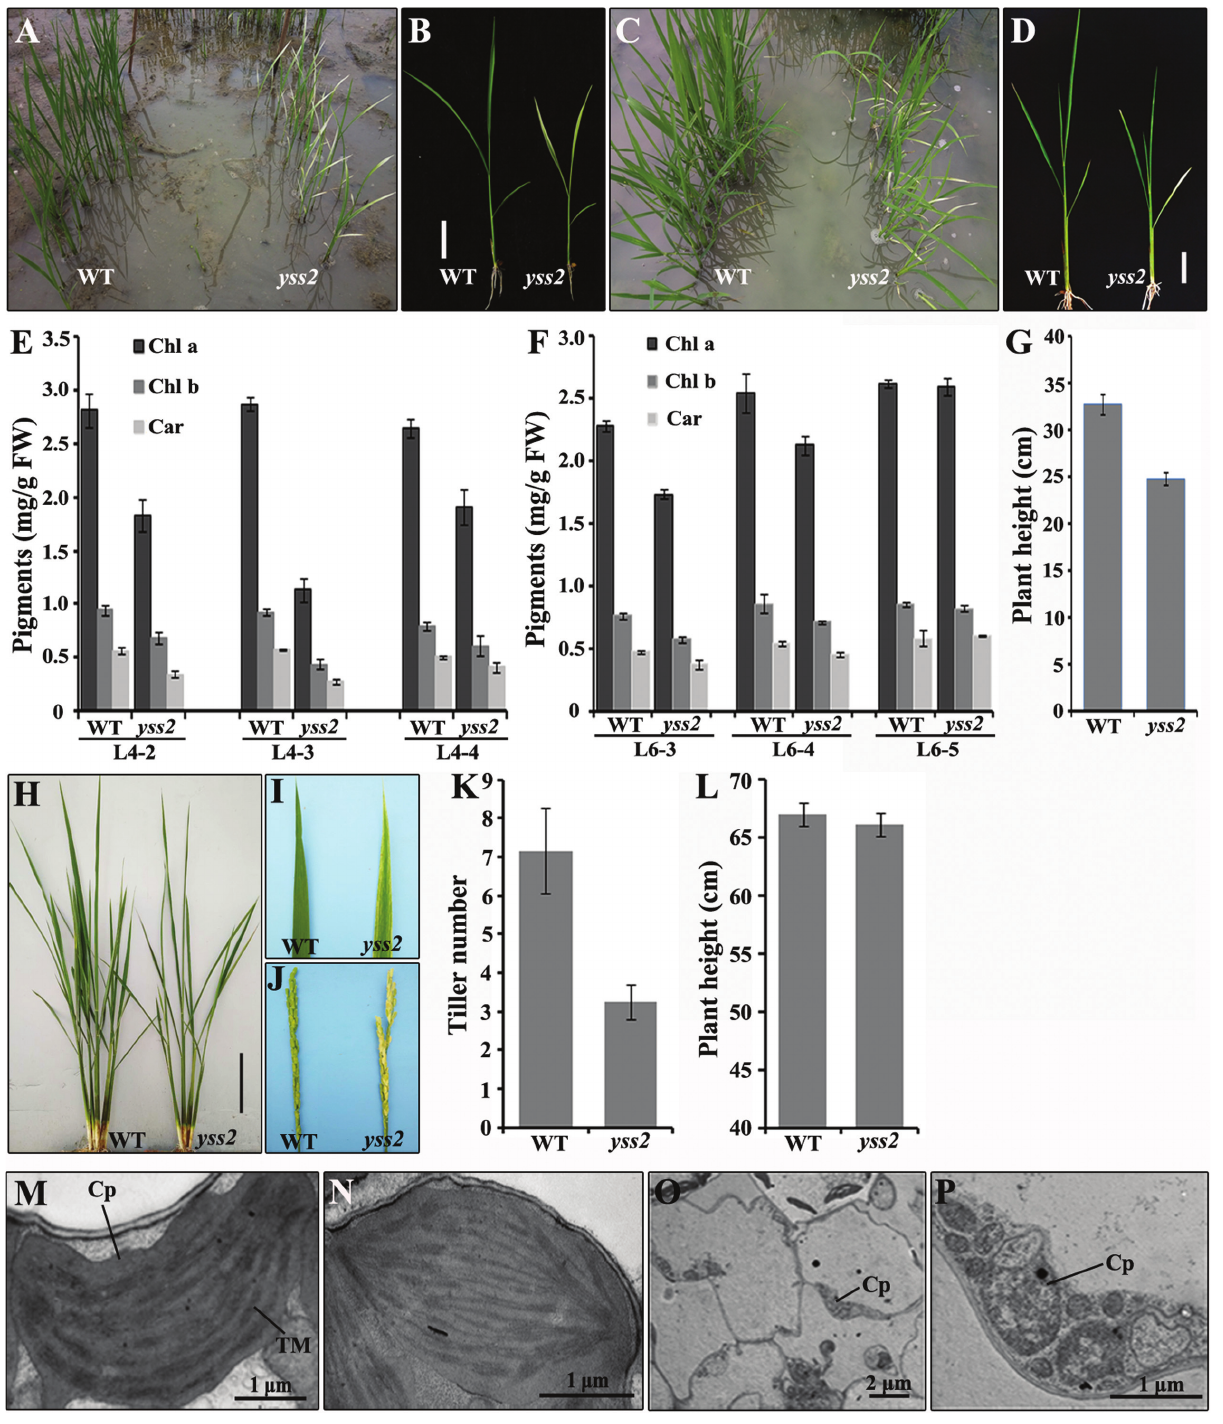
Figure 1 - Phenotypic characteristics of the yss2 mutant. Wild type and yss2 mutant plants at the four-leaf (A, B) and six-leaf (C, D) stages in a paddy field. Bars , 5 cm. Pigment contents of the wild-type and yss2 mutant plants in different leaf sections at the four-leaf (E) and six-leaf (F) stages ( e.g. , L4-2, L4-3separatelyrepresentthesecondandthirdleavesattheL4growthstage).Valuesaremeans (cid:4) SDfromthreeindependentdeterminations.(G)Heights of wild type and yss2 mutant at the six-leaf stage. Values are means (cid:4) SD from five independent repeats. (H) Phenotypes of wild type and yss2 mutant at themaximumtilleringstage. Bar ,10cm.(I,J)The yss2 mutantexhibitingstriatedleavesandwhitepaniclesafterheading.(K,L)Tillernumbersandplant heights of wild type and yss2 mutant after heading. Electron micrographs showing ultrastructures of chloroplasts from leaf 3 of wild type (M) as well as the green (N) and chlorotic sections (O, P) of leaf 3 in the yss2 mutant at the three-leaf stage. Cp, chloroplast; TM, thylakoid membrane